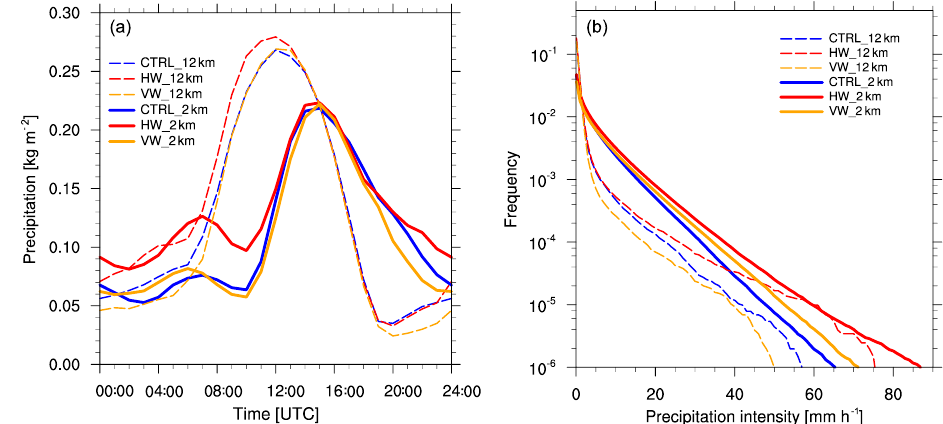
Figure 4. (a) Spatially and temporally averaged diurnal cycles of precipitation for 3–13 June 2007. (b) Frequency of hourly precipitation intensity for 3–13 June 2007 for the three 12km runs (dashed lines) and three 2km runs (solid lines). Control runs are indicated in blue, HW runs in red, and VW runs in orange.